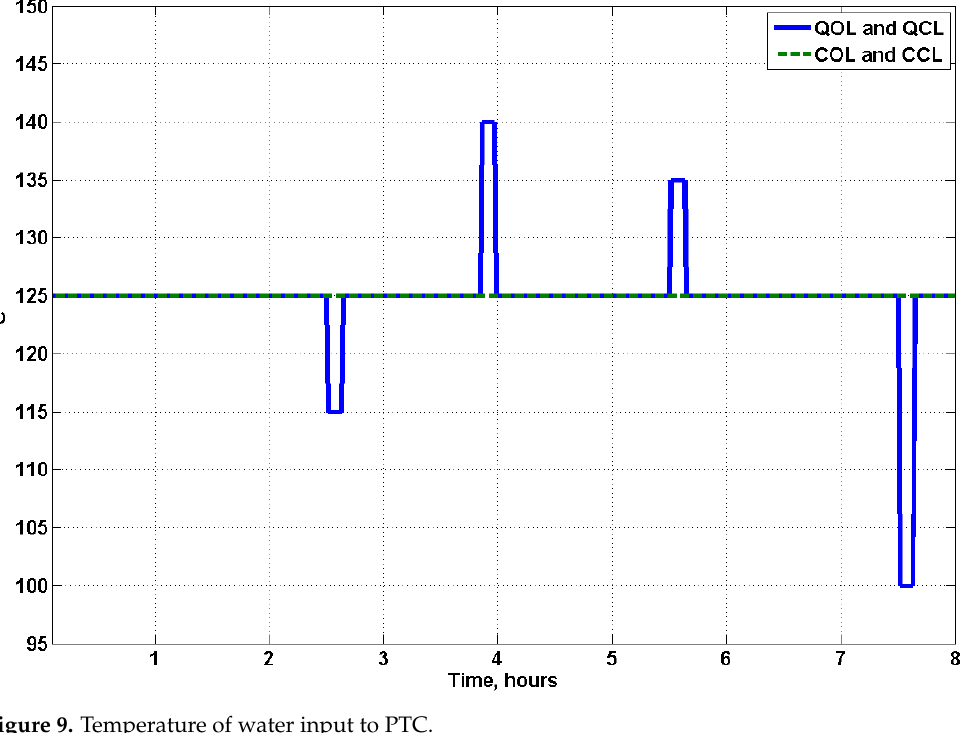
Figure 9. Temperature of water input to PTC.